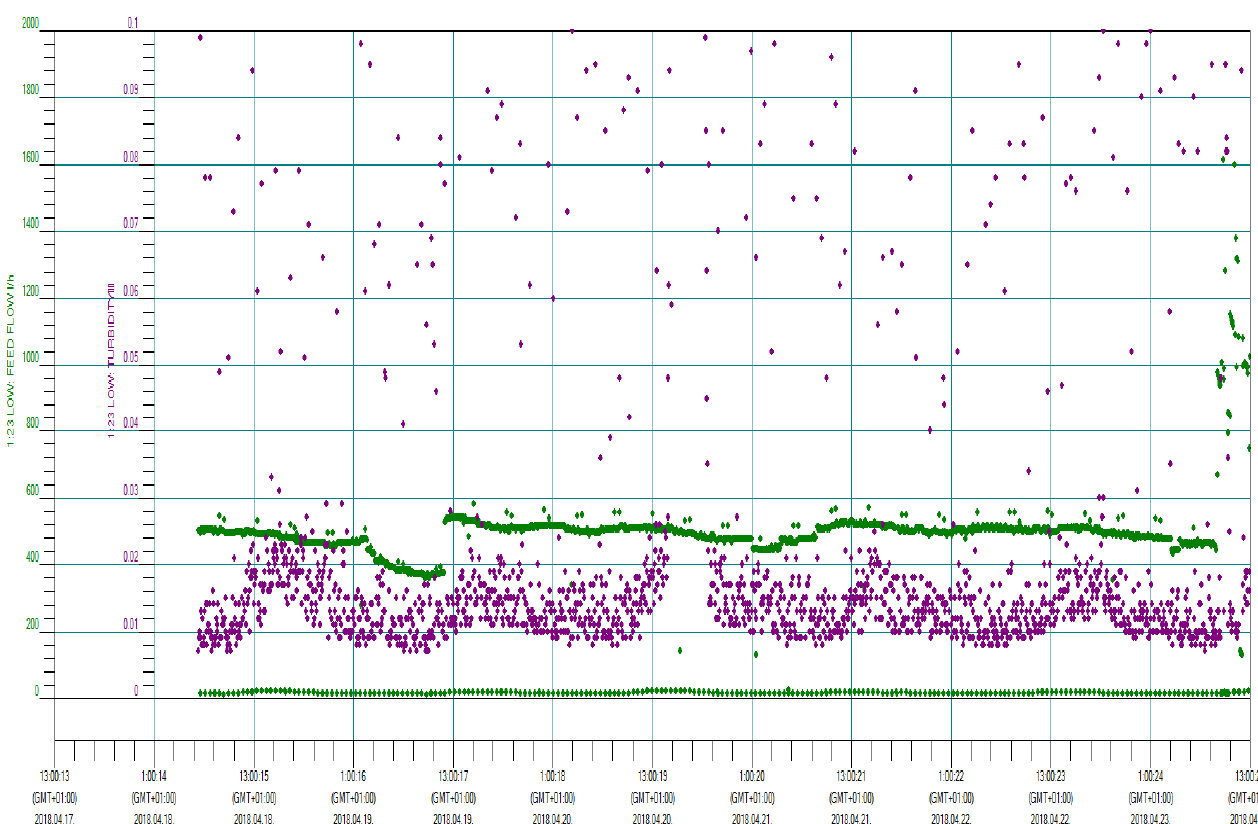
Figure A3. Flow and permeate turbidity (low resolution).